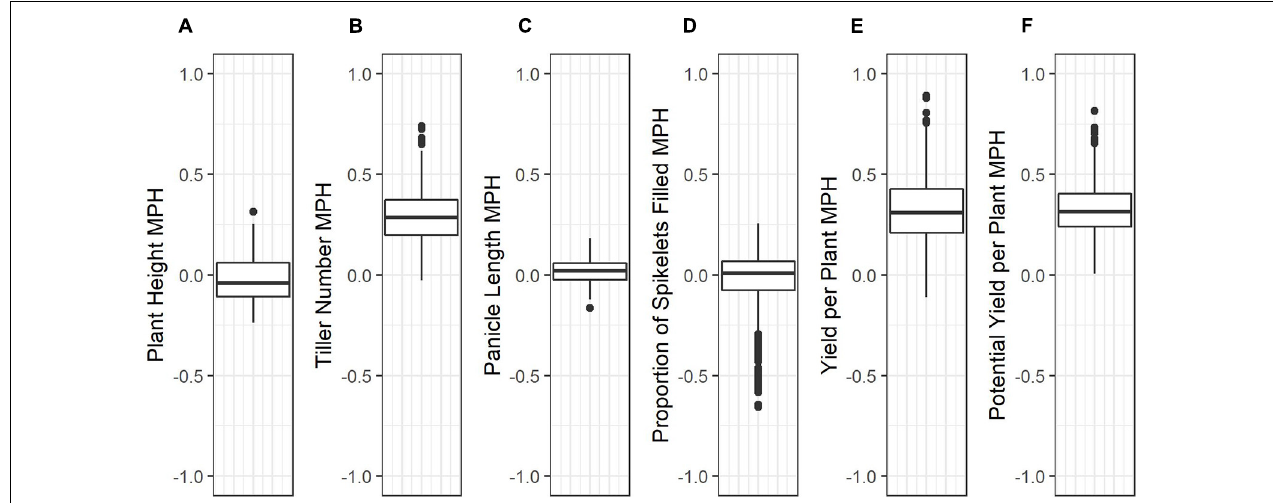
FIGURE 2 | Box plots of mid-parent heterosis for each trait in the phenotyped F 1 hybrids. (A) Plant height (cm). (B) Tiller number. (C) Panicle length (mm). (D) Proportions of spikelets filled. (E) Yield per plant (g). (F) Potential yield per plant (g).